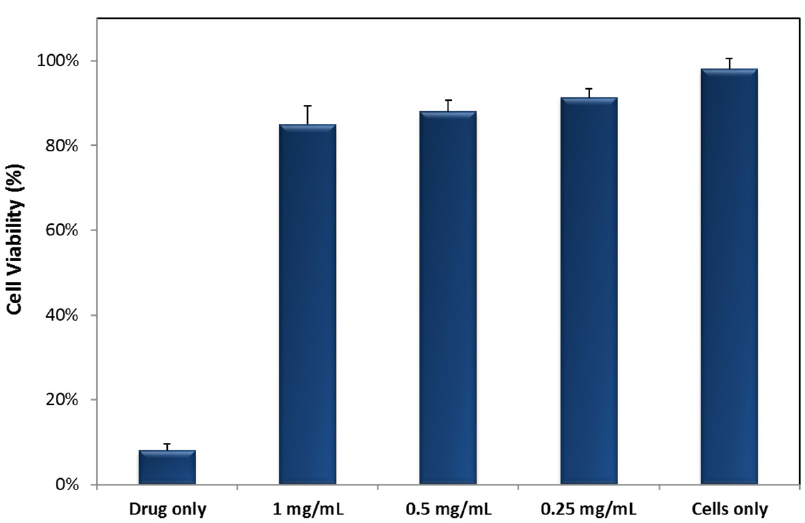
Figure 9. MTT cell viability assay for MDA-MB-231 metastatic breast cancer cells incubated with different concentrations of Fe 3 O 4 MNPs or the free anticancer drug doxorubicin. The results clearly show the low toxicity of MNPs, while the free drug is shown to be considerably toxic, killing almost all the cells.